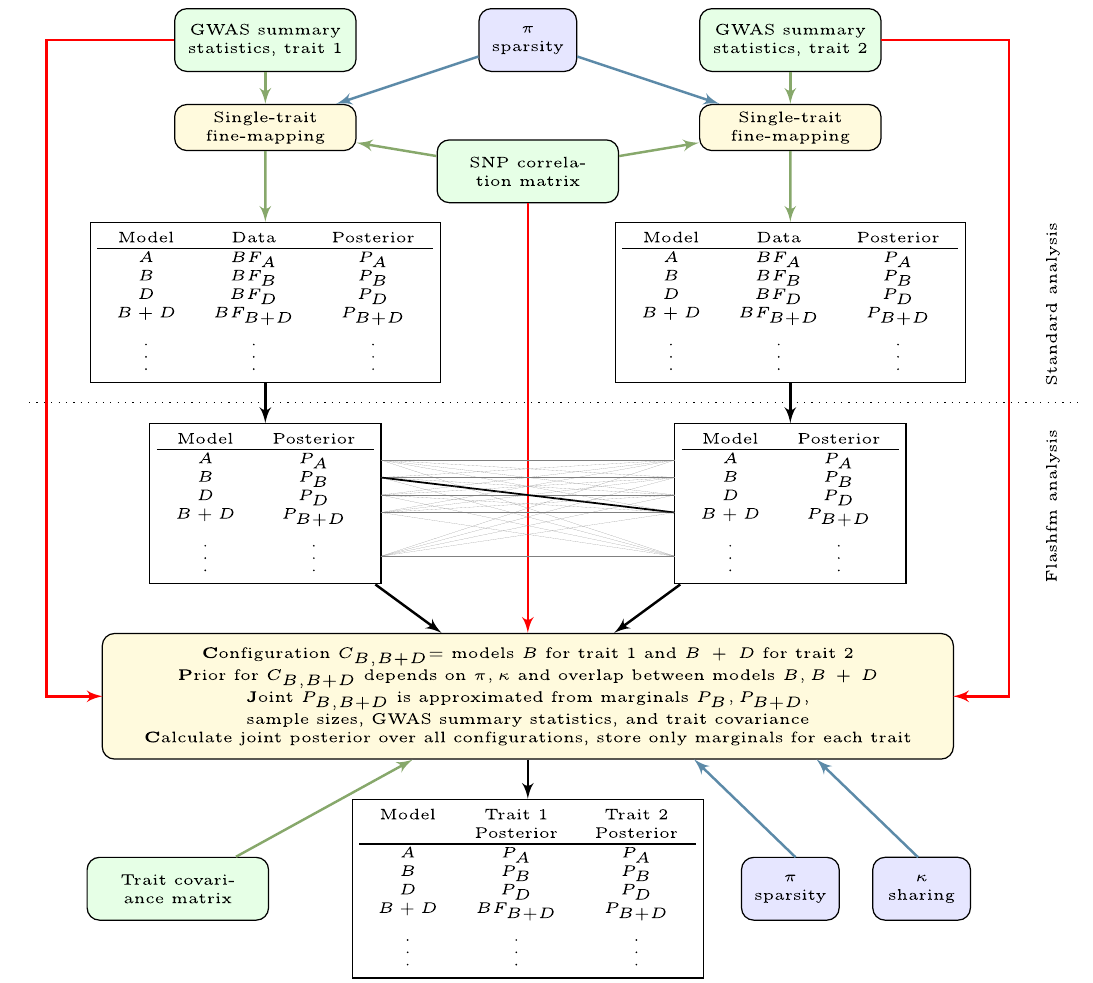
Fig. 1 Schematic diagram for fl ashfm. Flashfm is used for multiple quantitative traits that are measured in the same studies, allowing for missing measurements and family data. First, standard analysis of single-trait fi ne-mapping is needed for each trait. Then the model posterior probabilities (PPs) from each of these marginal fi ne-mapping analyses are combined in fl ashfm, using an approximation to the joint PP, based on an approximation of the joint Bayes ’ factor. In addition to a SNP correlation matrix, a trait covariance approximation is also needed. Information is shared between traits via a sharing prior that upweights joint models with shared causal variants by a factor of Ҝ . Memory requirements are reduced by storing only the trait-adjusted marginal PPs for each